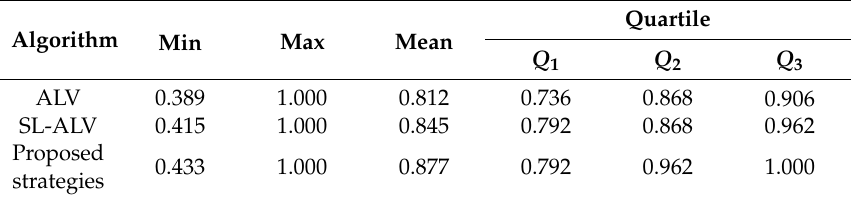
Table 2. Statistics of RR values.